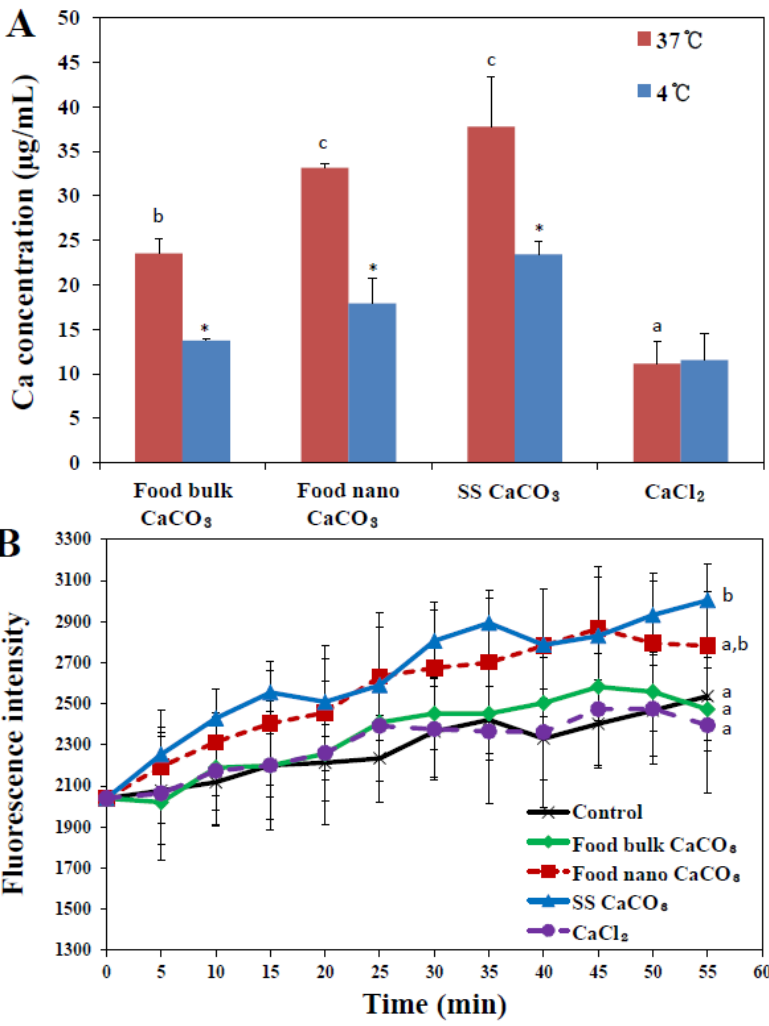
Figure 5. ( A ) Cellular internalization of three different types of CaCO 3 particles or an equivalent amount of CaCl 2 (based on calcium content) in human intestinal INT-407 cells after 2 h of incubation, as measured by inductively coupled plasma-atomic emission spectroscopy (ICP-AES); ( B ) intracellular Ca 2+ levels monitored with Calcium Green™ − 1 probe (Life Technologies, Carsbad, CA, USA). The mean values with different letters (a, a,b, b) at the same temperature or time points indicate statistically significant difference ( p < 0.05). * denotes significant difference in uptake amount between 37 and 4 °C ( p <